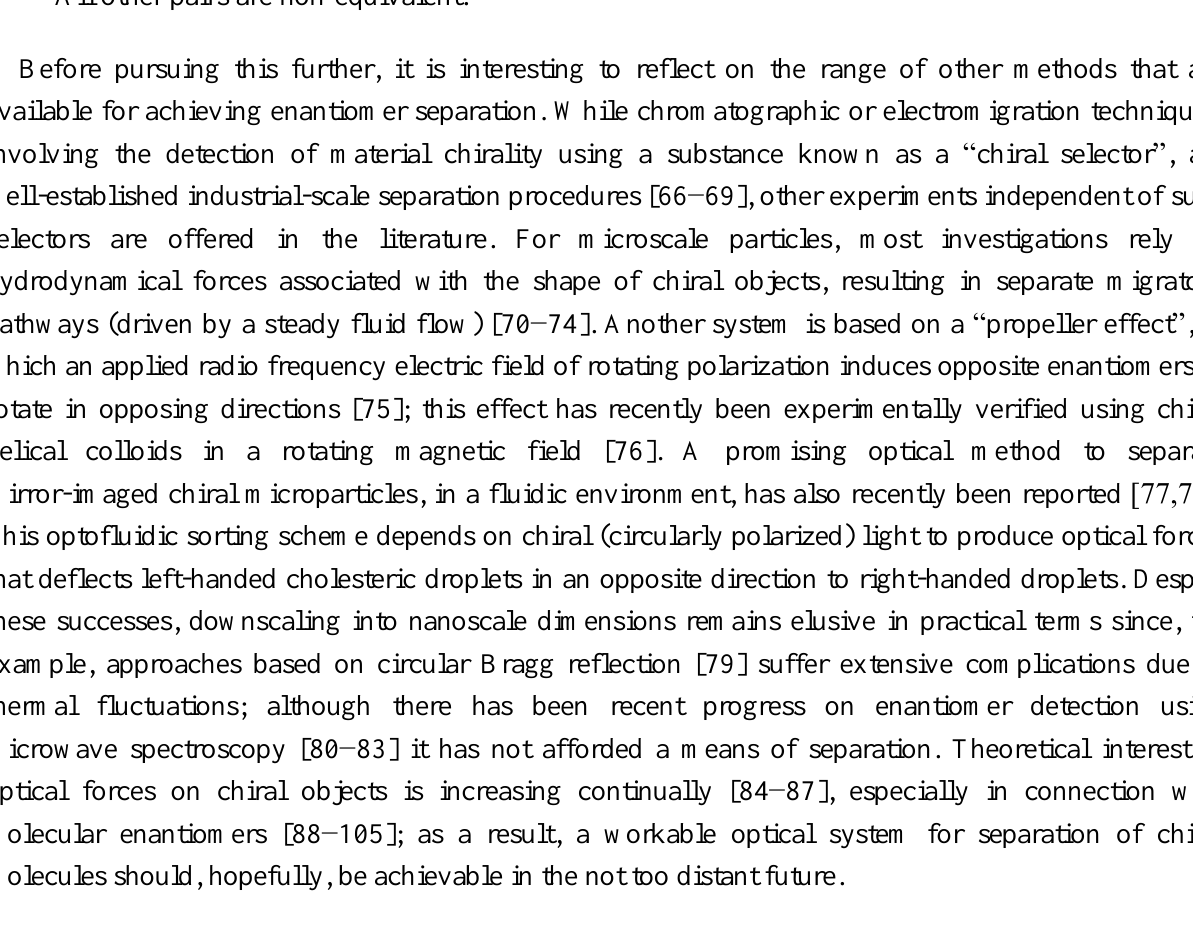
Figure 1. Illustration of the equivalences ( a ≡ b , c ≡ d ) between the discriminatory optical trapping forces for chiral molecules of different handedness (depicted by red and green spheres) irradiated by circularly polarized light of either handedness (right- and left-handed forms shown with opposite twist) propagating in the direction shown by the black arrows. All other pairs are